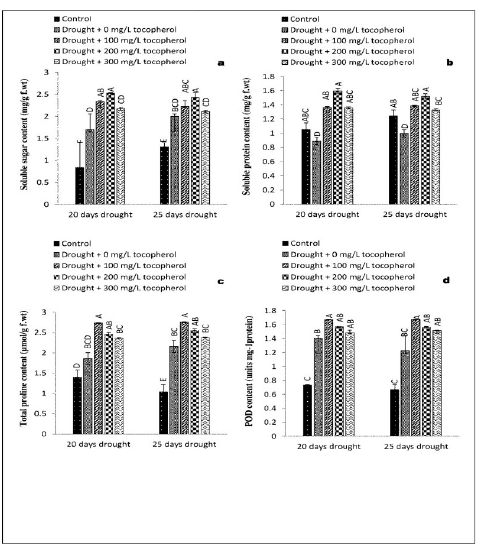
Fig 5. Effect of varying levels of exogenously applied α -tocopherol on soluble sugar content ( a )soluble protein content ( b ) total proline content ( c ) peroxidase content ( d ) of lentil ( Lens culinaris Medik.) grown under varying drought stress condition (Mean ± standard error.) letters (A–F) indicating least significance difference among the mean values at p �